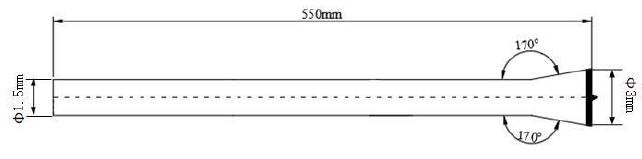
Figure 5. The structure of microdrill.